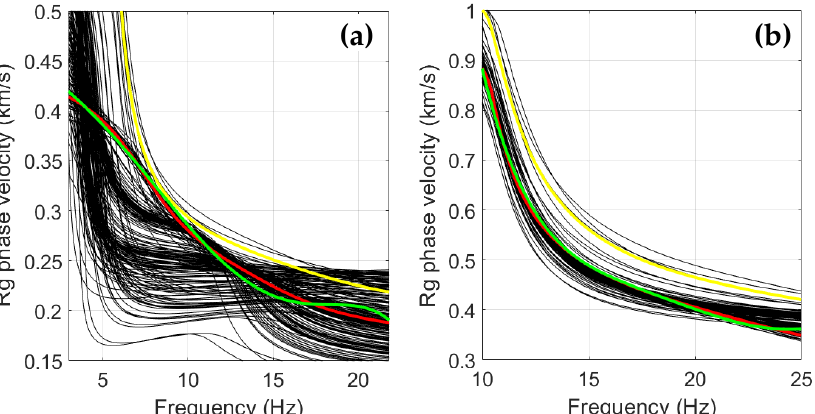
Figure 3. Examples of Rayleigh wave phase velocity dispersion curves at different places (see Figure 2). Experimental dispersion curve (green color), dispersion curve obtained from the initial model (yellow), dispersion curves obtained during the inversion process (black lines), and theoretical dispersion curve for the final model (red line) are shown. ( a ) A2 site (flood plain); ( b ) A8 site (hill with a gentle slope).